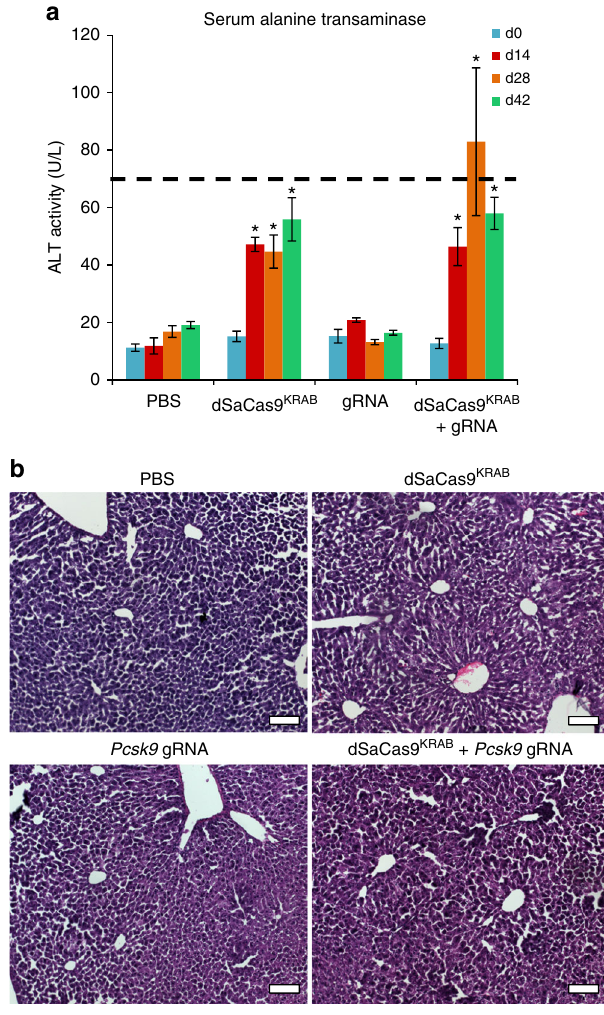
Fig. 4 Transient effects of AAV-mediated dSaCas9 KRAB gene silencing